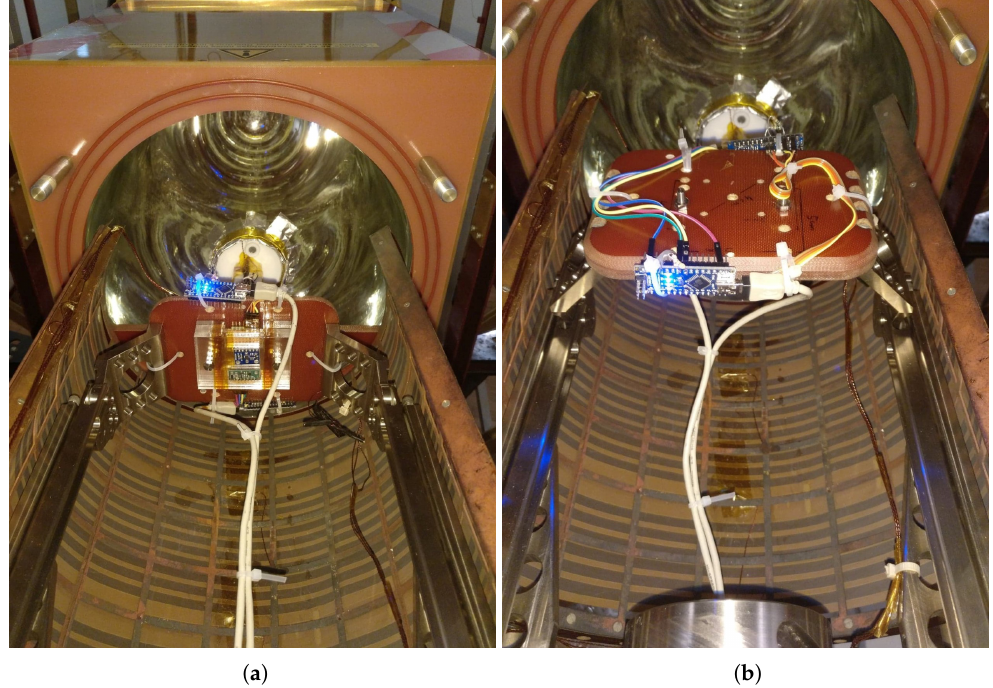
Figure A2. Inside view of the measurement box (the yellow box in Figure 1). The underlying grid forming a semicircle inside the box is the heating system (here, the whole structure is pulled out of the box). The sensors being tested are fixed on the transparent plastic structure (see the middle of ( a )), which is screwed to the brown holding plate. This plate can be turned, as is shown in ( b ). All materials inside and outside the box are